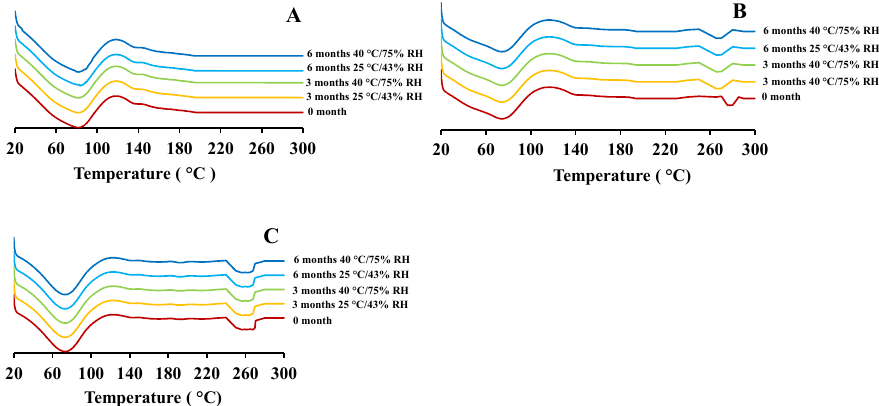
Figure 6. DSC thermograms of blank and CIP-loaded PEtOx NPs before and after 3 and 6 months of storage at 25 °C/43% RH and 40 °C/75% RH; ( A ) blank PEtOx NPs; ( B ) 5 mg CIP-loaded PEtOx NPs; ( C ) 25 mg CIP-loaded PEtOx NPs.